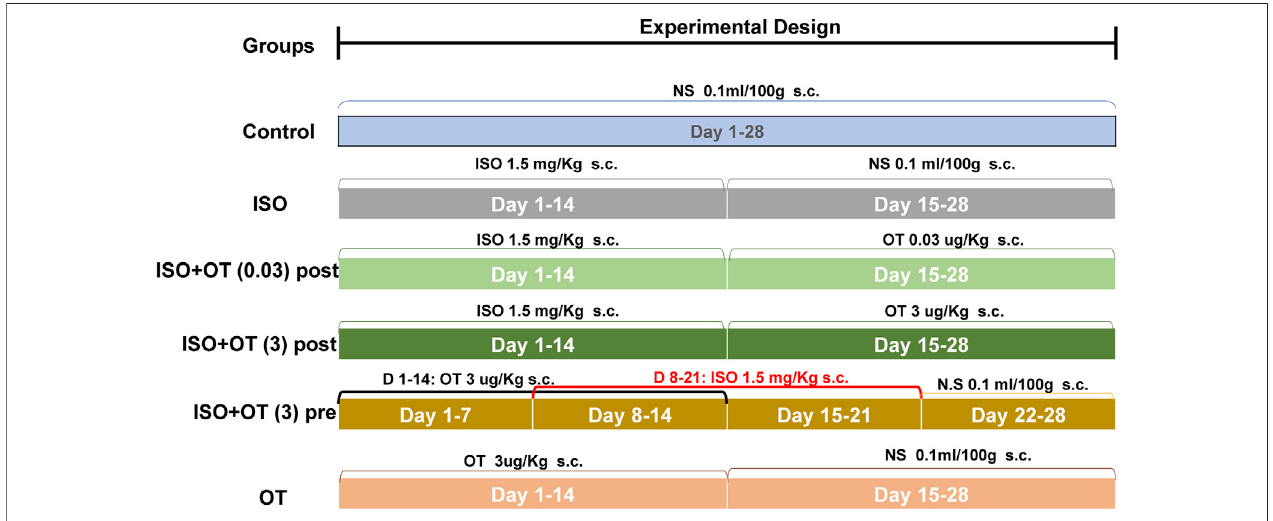
FIGURE 1 | Illustration of the experimental protocols. NS, Normal Saline; ISO, Isoproterenol; OT, oxytocin; OTpost, oxytocin postconditioning; OTpre, oxytocin preconditioning; s.c, subcutaneous.